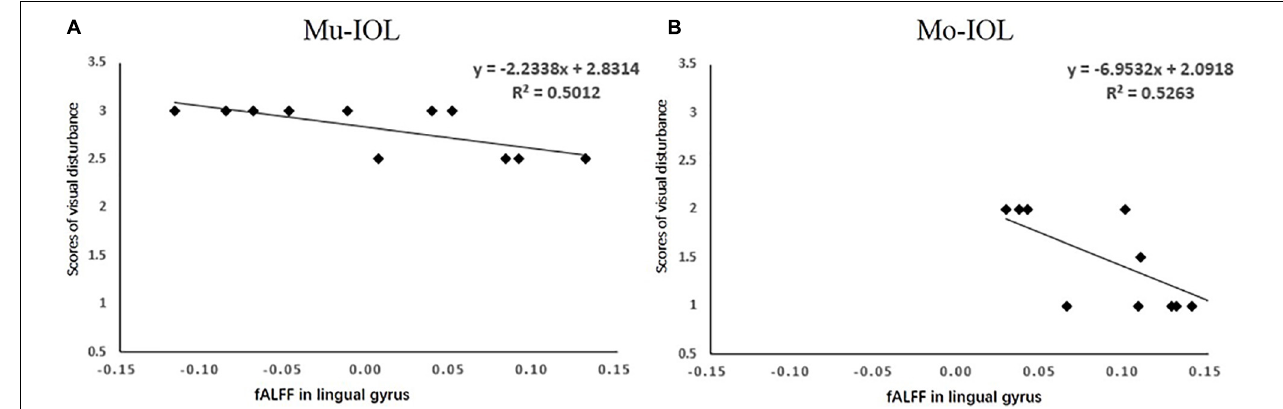
FIGURE 4 | Relationships between the mean of visual disturbances and the fALFF value in the lingual gyrus in the Mu-IOL group (A) and in the Mo-IOL group (B) . No significant correlations were noted between visual disturbance and visual function. fALFF, the fractional amplitude of low-frequency fluctuations; Mo-IOL, monofocal intraocular lens; Mu-IOL, multifocal intraocular lens.